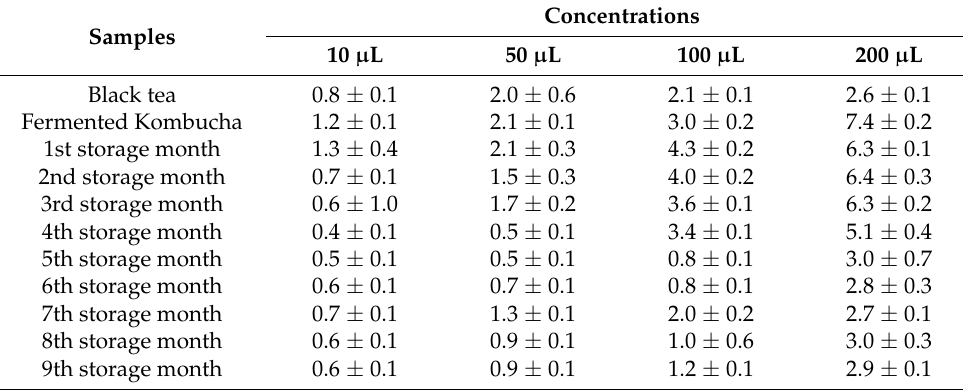
Figure 6. %I DPPH of Trolox, black tea, kombucha tea after 30 days of fermentation and all the samples during storage. White bar refers to %I DPPH of kombucha tea after 30 days of fermentation (control), the others refer to kombucha samples over nine months of storage. Asterisks on the bars indicate that mean values were statistically different from the control (* p < 0.05, *** p < 0.001, **** p < 0.0001). Table 2. Trolox equivalent antioxidant capacity (TEAC) values (µg TE mL −1 ) of different samples against DPPH.